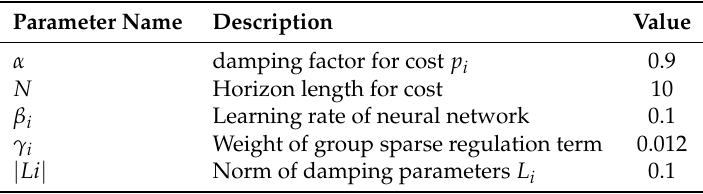
Table 2. Parameter of the controller in the IEEE 14 bus test